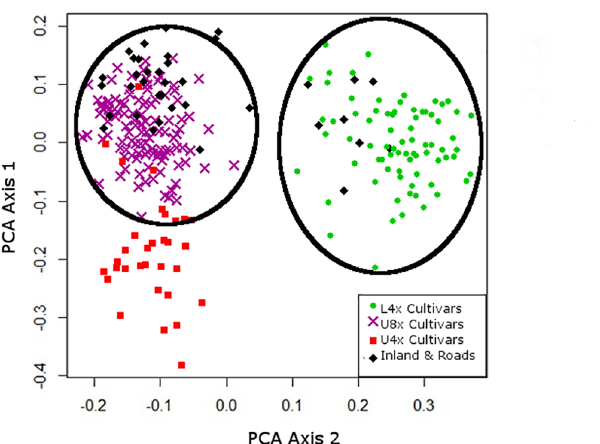
Fig 5. Principle Coordinate Analysis (PCA) of SSR markers from switchgrass collected from inland road verges and 18 U4x, U8x, and L4x switchgrass cultivars (n = 265). Circles indicate inland road plants clustering with either U8x or L4x but not U4x cultivars. Colors indicate: U4X cultivars (Red & ), U8X cultivars (PurpleX), L4X cultivars (Green ● ), plants from inland road verges (Black ♦ ).